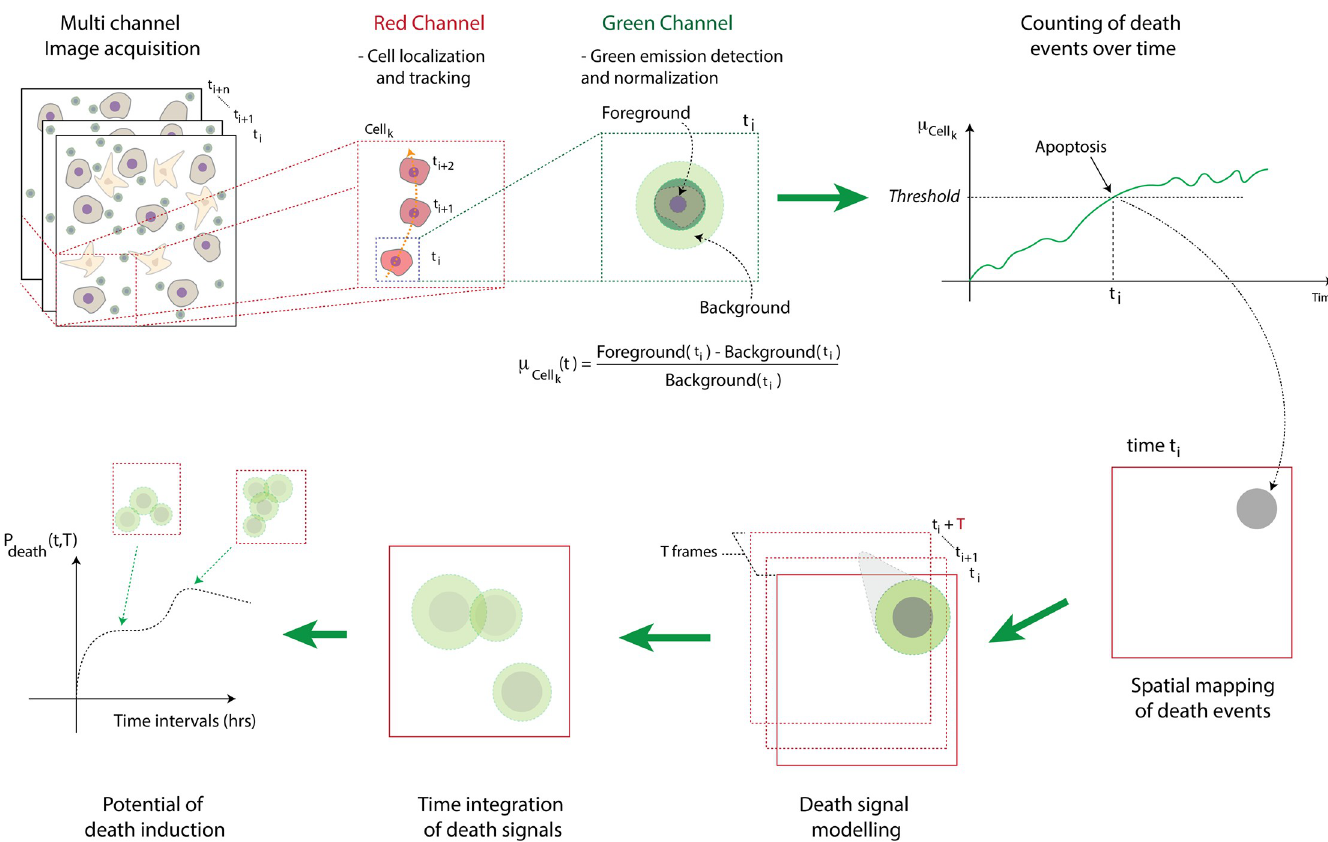
Fig 1. Description of the STAMP method. From multi-channel videos of ToC co-cultures, the cancer cells (pre-stained in red) are localized and tracked in the red channel. The dying cancer cells (becoming green because of the caspase reporter) are identified in the green channel, after signal normalization and thresholding. The method monitors cancer cell deaths both in time and in space. The death signal is modeled to vanish during T time frames. Then, the spatiotemporal features of all death signals are integrated in a unique map, from which a parameter, named potential of death induction ( P death ), is computed over time (see Materials and Methods for